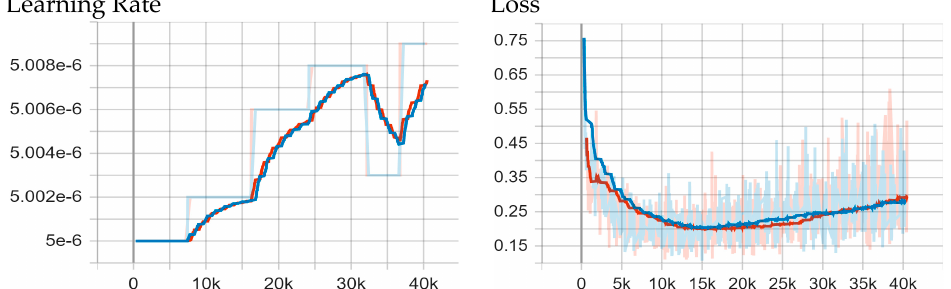
Figure 6. Output of the Learning Rate ( left ) and Loss ( right ) function. The blue and red lines represent actual and targeted learned values, respectively. The left side of the learning rate figure y axis represents given parameter learning rate variation value and the x axis represents training epoch numbers. The right side of the image y axis represents loss variation values and the x axis is training epoch value. The shadow copies of trained variables and ops that maintain a moving average of the trained variables in their shadow copies are shown.